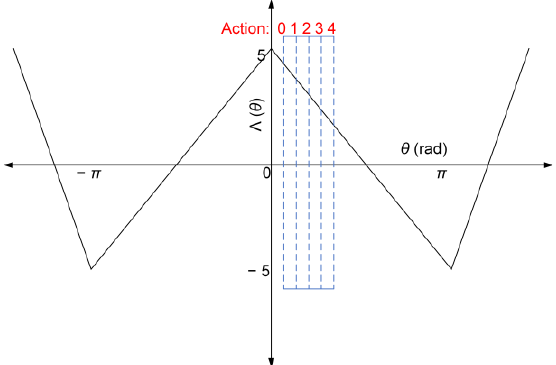
Figure 4. Angular direction illustration.